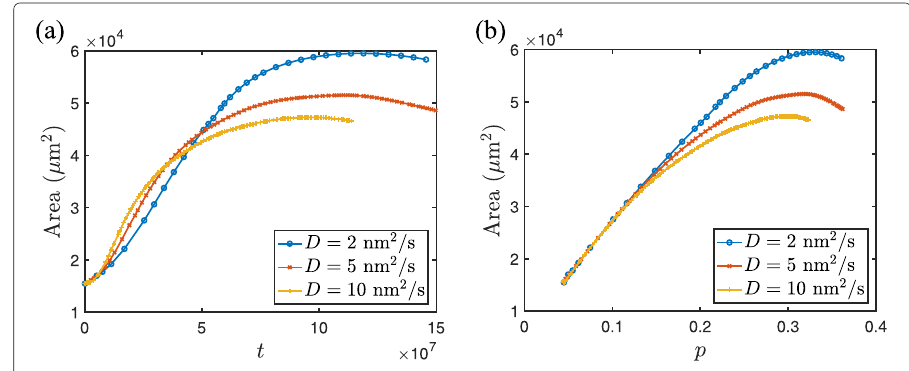
Fig. 4 Surface areas as a function of a time and b porosity (initial conditions of Configuration